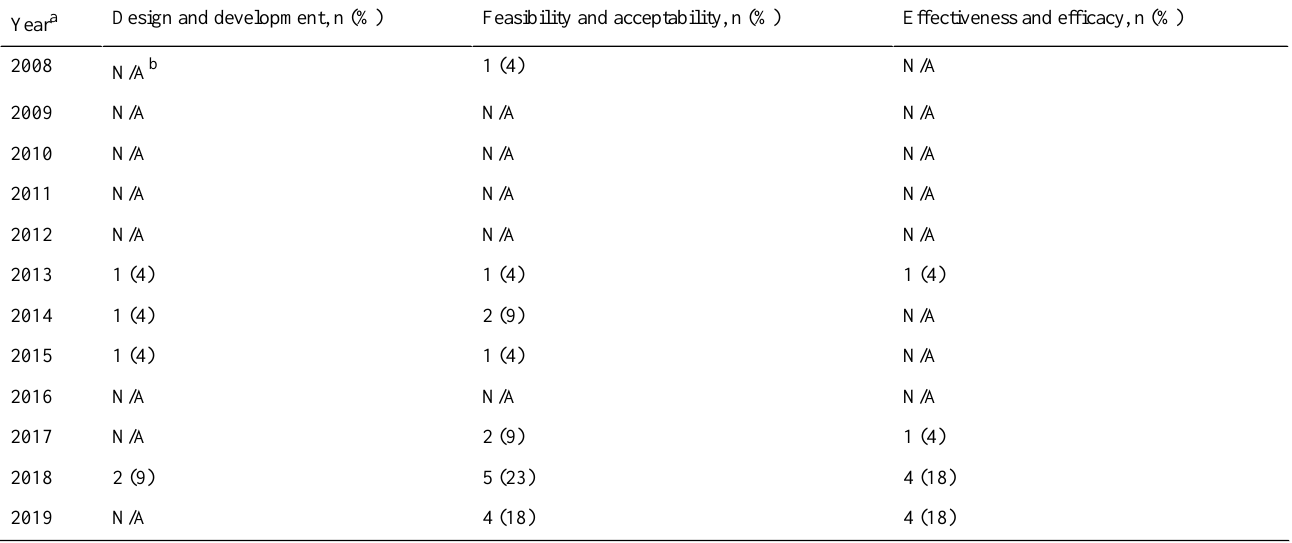
Table 1. Study phase over time, based on year of publication (N=22